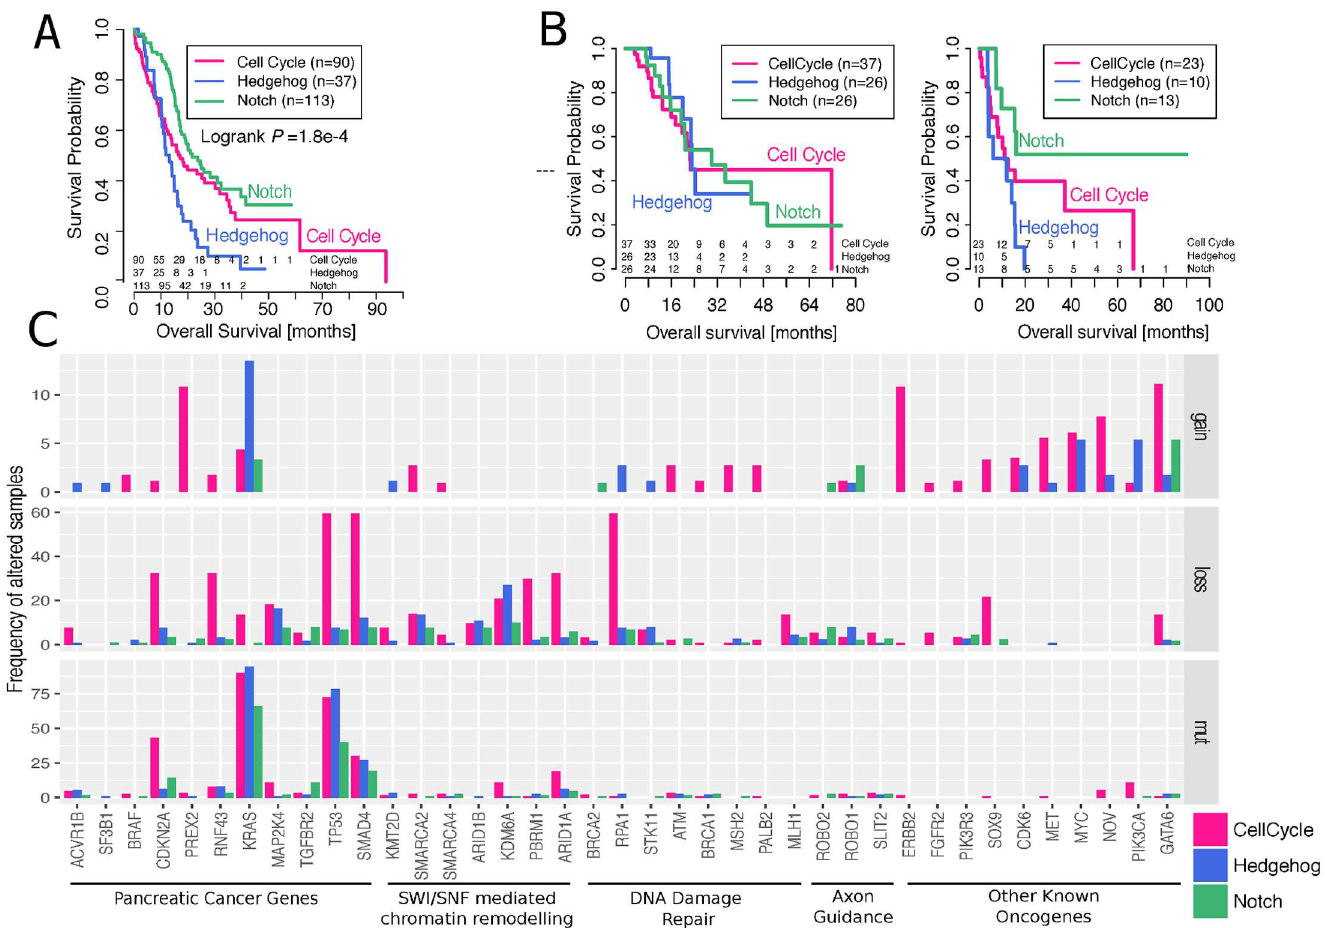
Fig 3. Differences in survival and mutational burden between subtypes. A. Kaplan–Meiersurvival curves of the different tumour subgroups using the ICGC cohort. Numbers of subjects at risk at the start of each time intervalare shown above the x -axis. The groups overall showedsignificantsurvival differences (logrank p -value= 1.8e–4).More specifically,Hedeghog/Wnt group HR = 1.73, 95% CI 1.1 to 2.72, coxPH test p -value= 0.018; Notch group HR = 0.62, 95% CI 0.42 to 0.93, coxPH test p -value= 0.019; when comparedto the cell cycle group and after correcting for gender,age, and tumour stage. B. Kaplan–Meiersurvival curves of the different tumour subgroups using the TCGA cohort for subsets of individualsthat did or did not receive adjuvant targeted therapy treatment. Numbers of subjectsat risk at the start of each time interval are shown abovethe x -axis. Hedeghog/Wnt group HR = 4.12, 95% CI 1.2 to 13.8, coxPH test p -value= 0.02; when comparedto the cell cycle group and after correcting for gender, age, tumour stage, and radiationtherapy indicator. C. Mutations in key genes and pathways in pancreatic cancer. The upper and middle panelsshow the frequency of altered samplesby copy number changes(gains refer to amplifications of > 5 copies); the bottom panel shows the frequency of altered samples by nonsilentsingle nucleotide variants, small insertions, or deletionswith moderate-to-highbiologicaleffect.